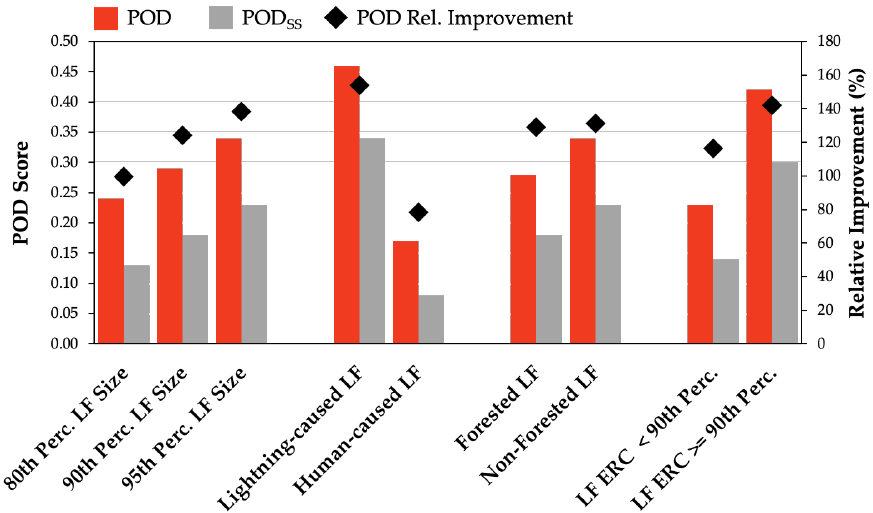
Figure7. Summary ofarea-widePOD, POD SS , andPOD relative improvement for thefour classifications Figure 7. Summary of area-wide POD, POD SS , and POD relative improvement for the four classifications of large fire day types. of large fire day